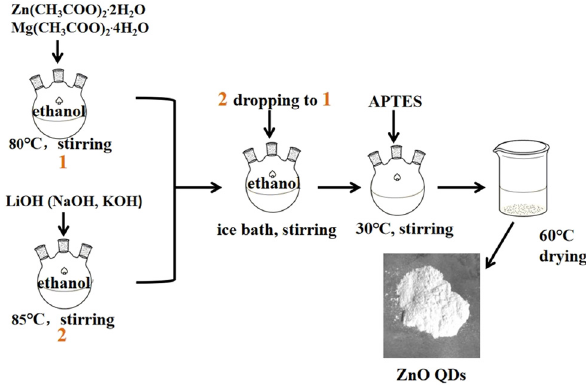
Figure 1: A typical routing of preparing ZnO QDs by the sol – gel